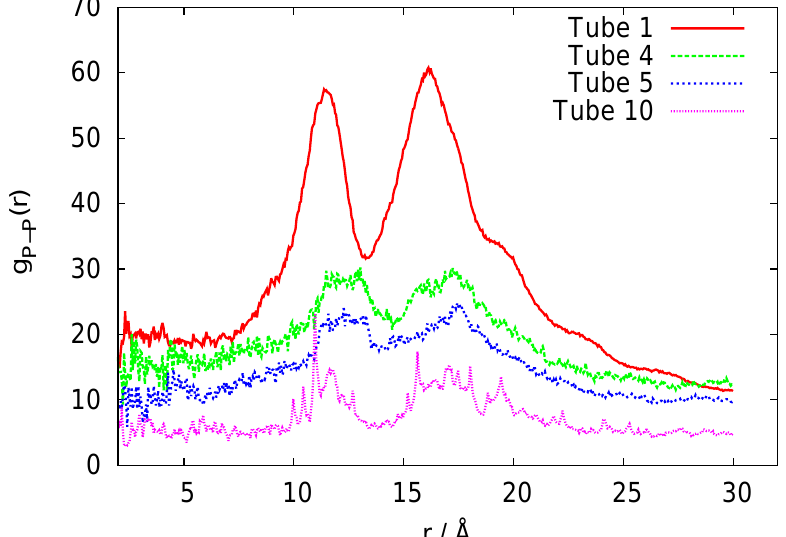
Figure 5. P-P Radial distribution functions for the coarse-grained models of 1-, 4-, 5-, and 10-ring RNA